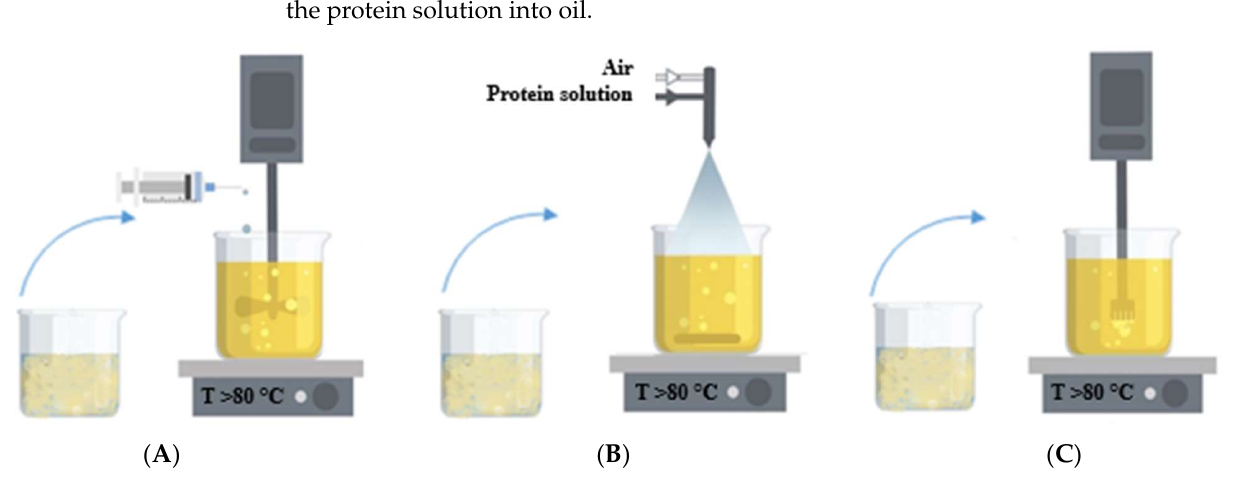
Figure 9. Dispersing methods of the protein solution into oil: ( A )—dripping; ( B )—spraying through a nozzle; ( C )—homogenization.